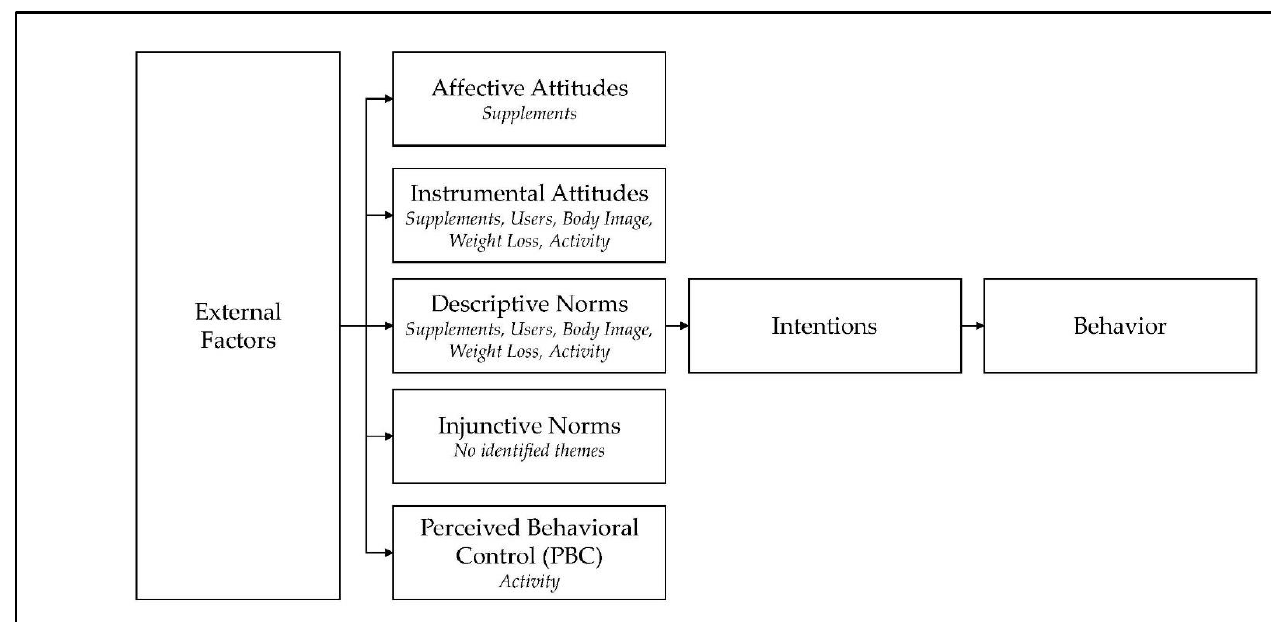
Figure 3. Theory of Planned Behavior with established concepts.